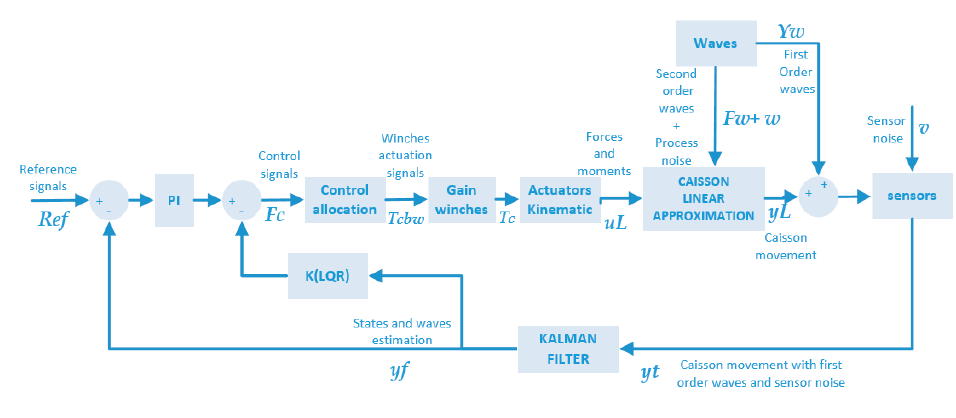
Figure 1. LQG control loop for dynamic positioning of caissons based on the KF.